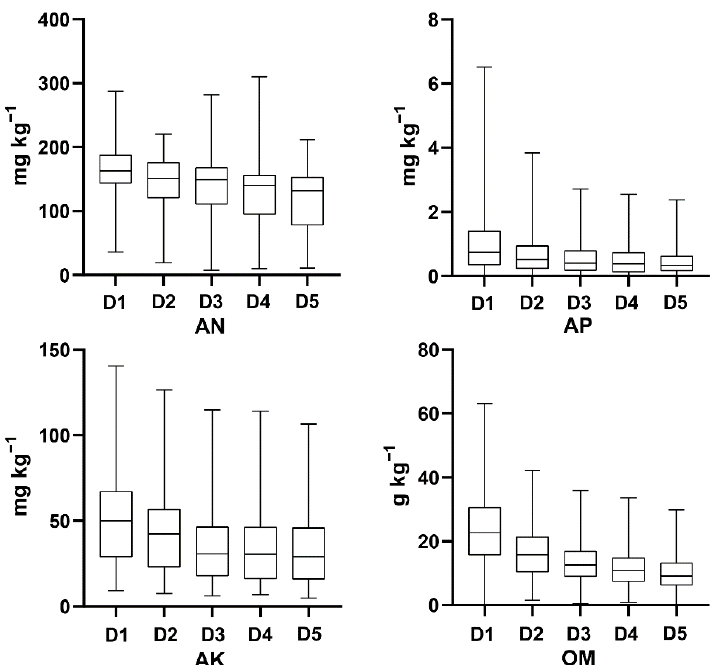
Figure 3. Descriptive statistics of available nutrients (mg kg − 1 ) and organic matter (g kg − 1 ). D1: 0–20 cm; D2: 20–40 cm; D3: 40–60 cm; D4: 60–80 cm; D5: 80–100 cm. AN: alkali-hydro-nitrogen; AP: available phosphorus; AK: available potassium; OM: organic matter.